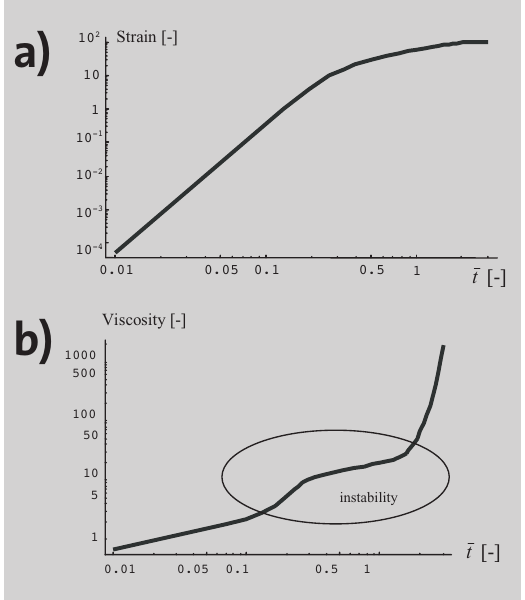
Figure 4 (left above): Numerical simulation of the creep test in sol - gel process: a) strain evolution in time; b) viscosity evolution in time (the instability region is remarked by the presence of inflexion points in the time variation of viscosity function, see also Fig. 2). Figure 5 (right above): Direct simulation of constitutive Eq. 10 in oscillatory test (onset and end of the process). Figure 6 (right below): Experimental and theoretical Lissajous figures: Oscillatory stress as function of oscillatory strain (with time parameter) associated with the dynamic test (sample